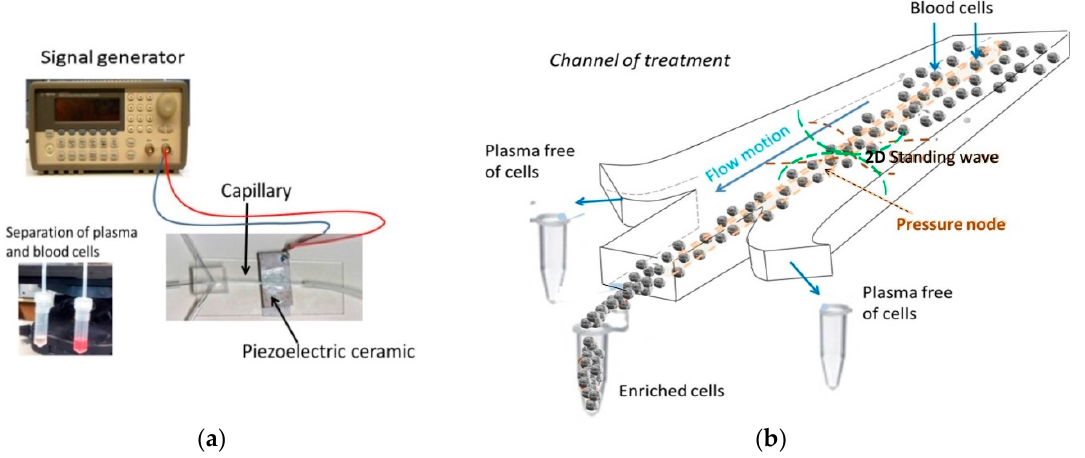
Figure 1. ( a ) Picture of the setup and ( b ) schematic of the plasmapheresis microchip actuated by ultrasound, governed by a resonance transverse to the channel length/flow motion.